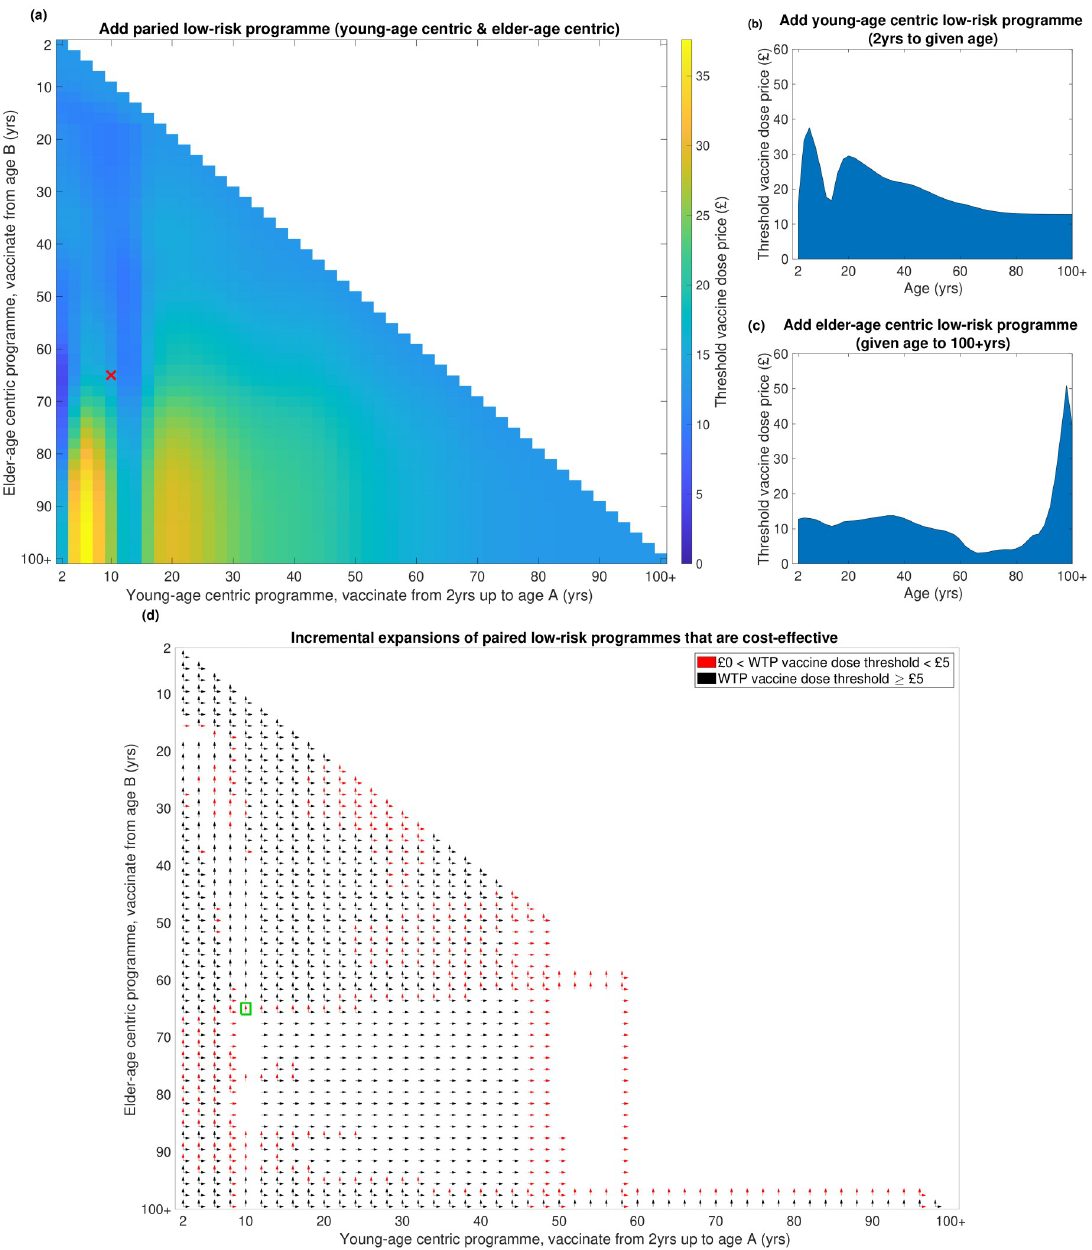
Fig 5. Threshold price per additional vaccine dose for additional vaccines required to add a low-risk vaccine programme (relative to an at-risk only vaccination programme). Threshold vaccine dose prices reflect the cost at which 90% of all simulations generate cost- effective results at a WTP of £30,000 per QALY, with 3.5% discounting for monetary costs and health effects. In all strategies we assumed 10% vaccine wastage and an administration fee per deployed vaccine of £10. (a) Paired low-risk programmes (combined young-age centric and elder-age centric coverage). Shading transitioning from dark shading to light shading depicts shifts from low to high prices. The white region corresponds to omitted strategies, where young-age centric and elder-age centric coverage would overlap. The red cross marks the coverage offered by the current seasonal influenza vaccine policy for England. (b) Addition of a low-risk young-age centric programme only. (c) Addition of a low-risk elder-age centric programme only. (d) Cost-effectiveness assessments of incrementally expanding paired low-risk vaccine programmes. Vertical arrows denote incremental expansions of the elder-age centric component (e.g. going from 70-100+yrs to 68-100+yrs) of a paired vaccination programme that were evaluated as cost-effective. Similarly, horizontal arrows denote incremental expansions of the young-age centric component (e.g. going from 2-10yrs to 2-12yrs) of a paired vaccination programme that were evaluated as cost-effective. The colour of the arrow distinguishes willingness to pay values per vaccine dose that were less than £5 (red) or £5 and above (black). The green box contains the assessment of incremental expansion from the current low- risk coverage offered by the seasonal influenza vaccine policy for England.